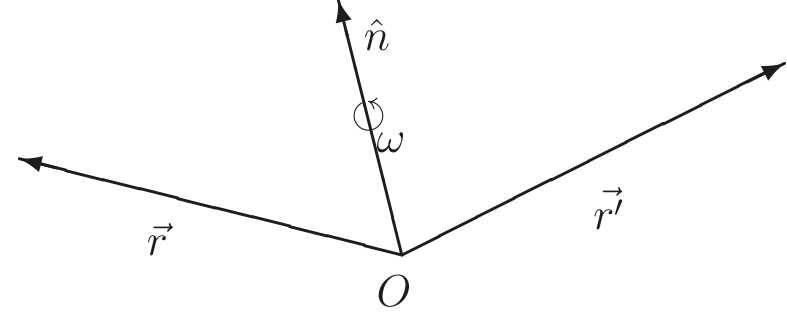
Figure 1. Rotation in space as determined by the unit vector ˆ n of the rotation axis and the rotation angle 0 ≤ ω < 2 π about the